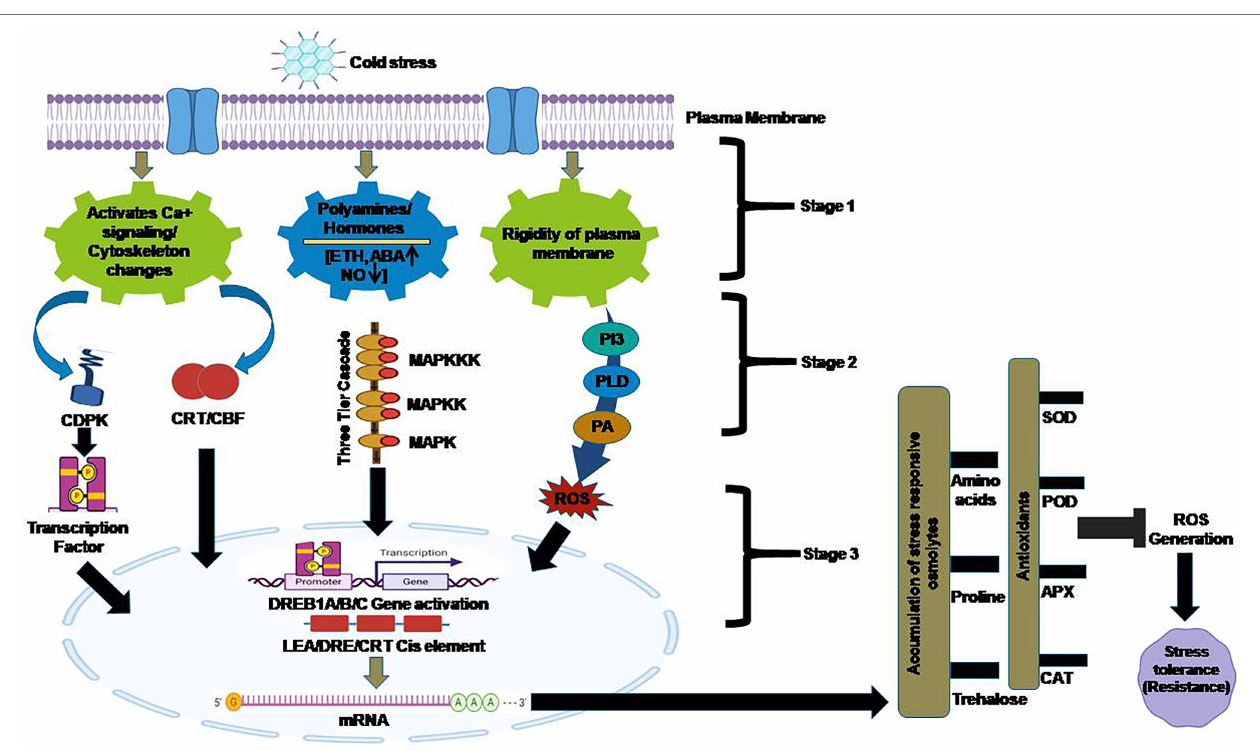
FIGURE 3 | Cold stress-induced signal transduction and response: Cold stress is perceived at the plasma membrane with activation of downstream signaling cascade viz activation of calcium signaling, polyamines and hormone signaling and rigidity of plasma membrane which in turn activates multiple cytoplasmic proteins and expression of different genes which ultimately leads to cold tolerance. CDPK: Calcium-dependent Kinases; CBF: C repeat binding factors; MAPK: Mitogen- activated protein kinase; ROS: Reactive oxygen